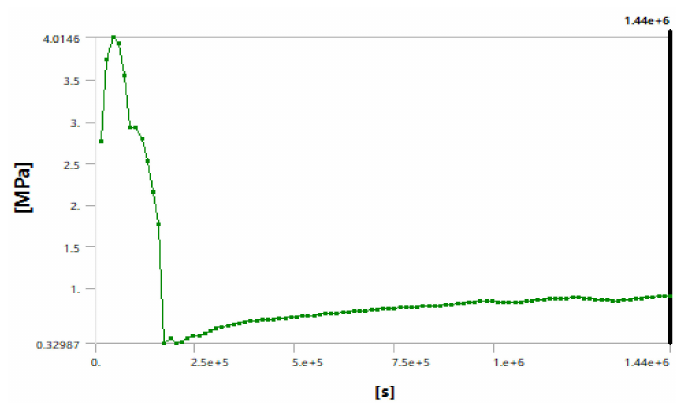
Figure 7. Stress–time curve for the cutter head.